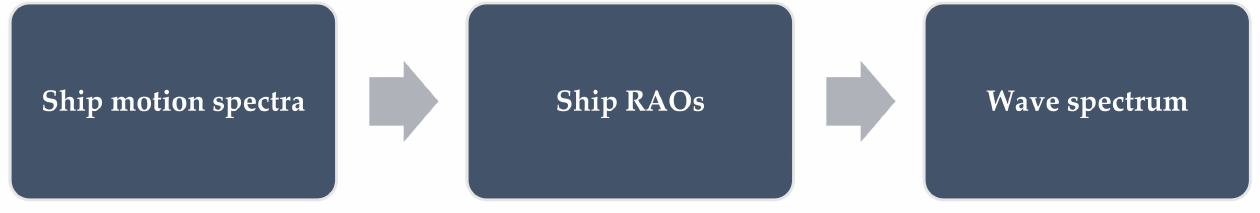
Figure 10. Sea state assessment by frequency domain